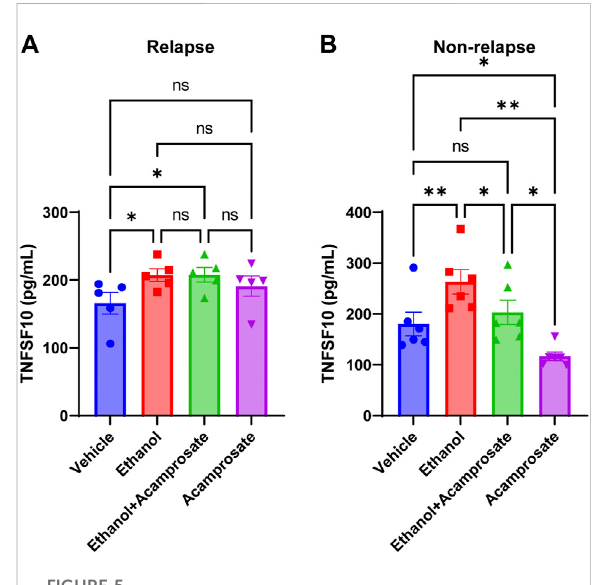
FIGURE 5 TNFSF10 concentrations were measured with and without drug exposure in LCLs derived from AUD patients with known acamprosate treatment outcomes. (A) Ethanol could induce TNFSF10 concentrations in LCLs derived from AUD patients who relapsed during 3 months of acamprosate treatment. However, acamprosate did not in fl uence TNFSF10 concentrations ( F (4, 12) = 6.420, p = 0.005). ELISA was performed in AUD patient- derived lymphoblastoid cell lines (LCLs). TNFSF10 concentrations were determined with and without treatment with EtOH (25 mM), or acamprosate (5µM) for 7 days. *A p value ≤ 0.05 was considered statistically signi fi cant. (B) Ethanol could induce TNFSF10 concentrations in LCLs derived from AUD patients who remained abstinent during 3 months of acamprosate treatment. However, acamprosate could decrease the levels of TNFSF10 ( F